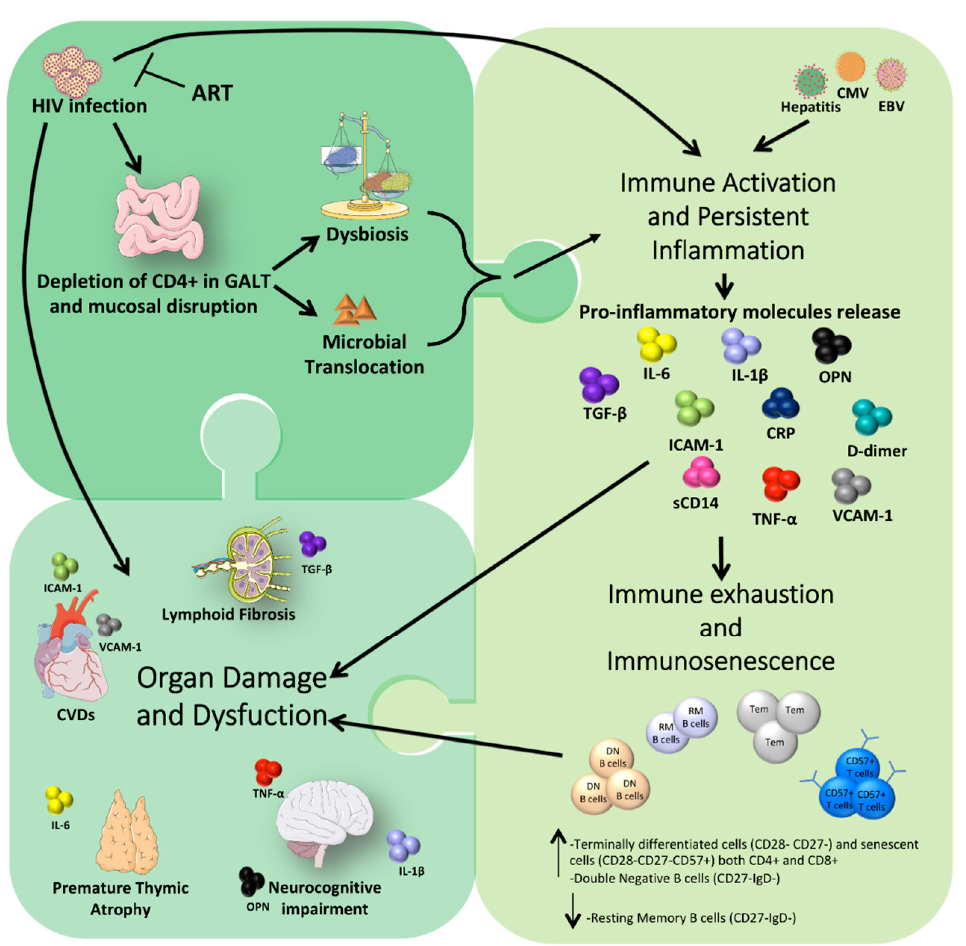
Figure 1. HIV infection causes both mucosal disruption and depletion of CD4+ T cells in gut-associated lymphoid tissue (GALT), altering the microbial composition (dysbiosis) and allowing microbial product to enter the circulatory system. Even with the introduction of antiretroviral therapy (ART), these two mechanisms lead to chronic immune activation and persistent inflammation that could also be enhanced by opportunistic co-infections. In turn, chronic activation and persistent inflammation result in (i) immune exhaustion and premature immune senescence, and in (ii) a direct damage of organs, through the release of pro-inflammatory cytokines. Images were obtained from Servier Medical Art images (http://smart.servier.com/).